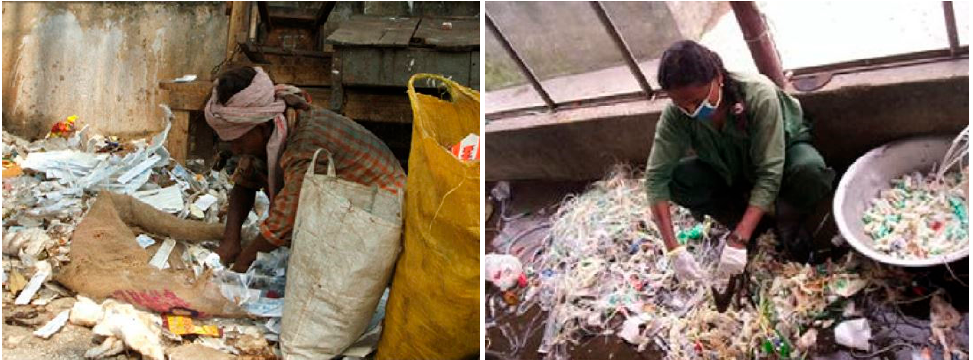
Figure 3. Informal HW scavenging in Dhaka, Bangladesh [87].